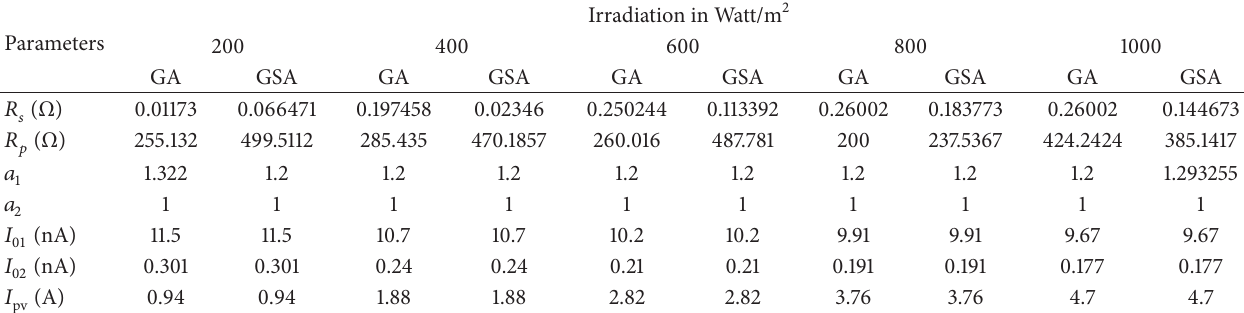
Table 3: Comparison of optimization results of GA and GSA at different irradiation levels for Shell